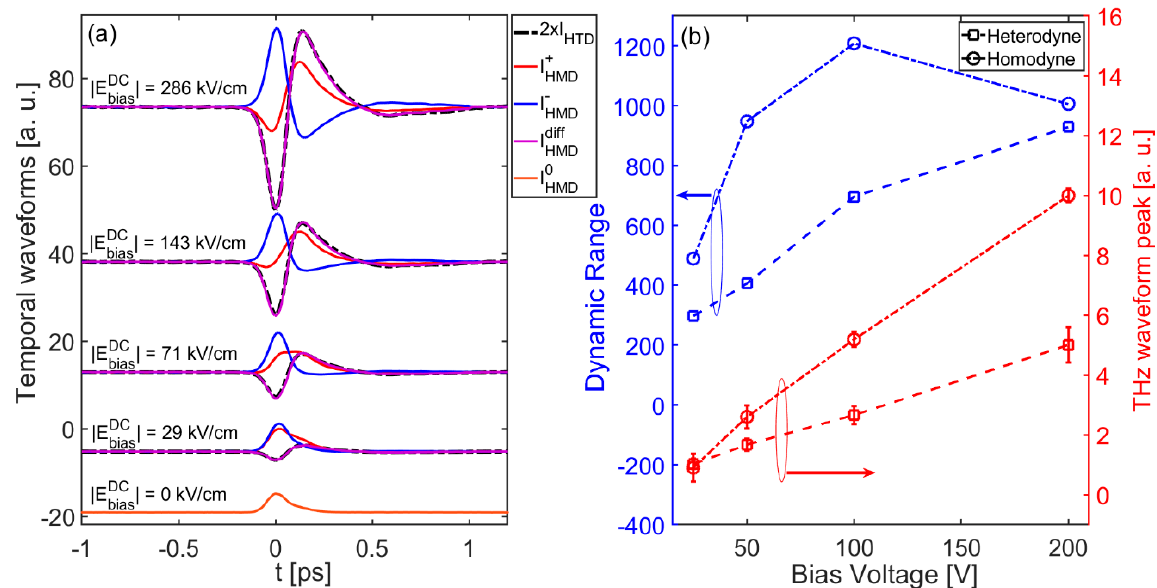
Figure 3. ( a ) Temporal waveforms acquired via the single-ended homodyne configuration, by varying the positive (red dotted curve) and negative (blue dashed line) E DC , and via the differential scheme (purple solid line), for a fixed E THz = 150 kV/cm. The dashed black lines represent the THz waveforms recorded via standard heterodyne scheme. Note that the heterodyne curves are multiplied by a factor of 2 for a convenient comparison with those retrieved via the differential homodyne scheme. All the curves are normalized with respect to the peak of the incoherent waveform I 0HMD (orange solid line) and vertically shifted for clarity. ( b ) Comparison between peak trends (red dots) and DRs (blue dots) corresponding to the case of differential homodyne (squares) and heterodyne (circles) detection. Dashed lines are only used to help the reader to visually link data points.